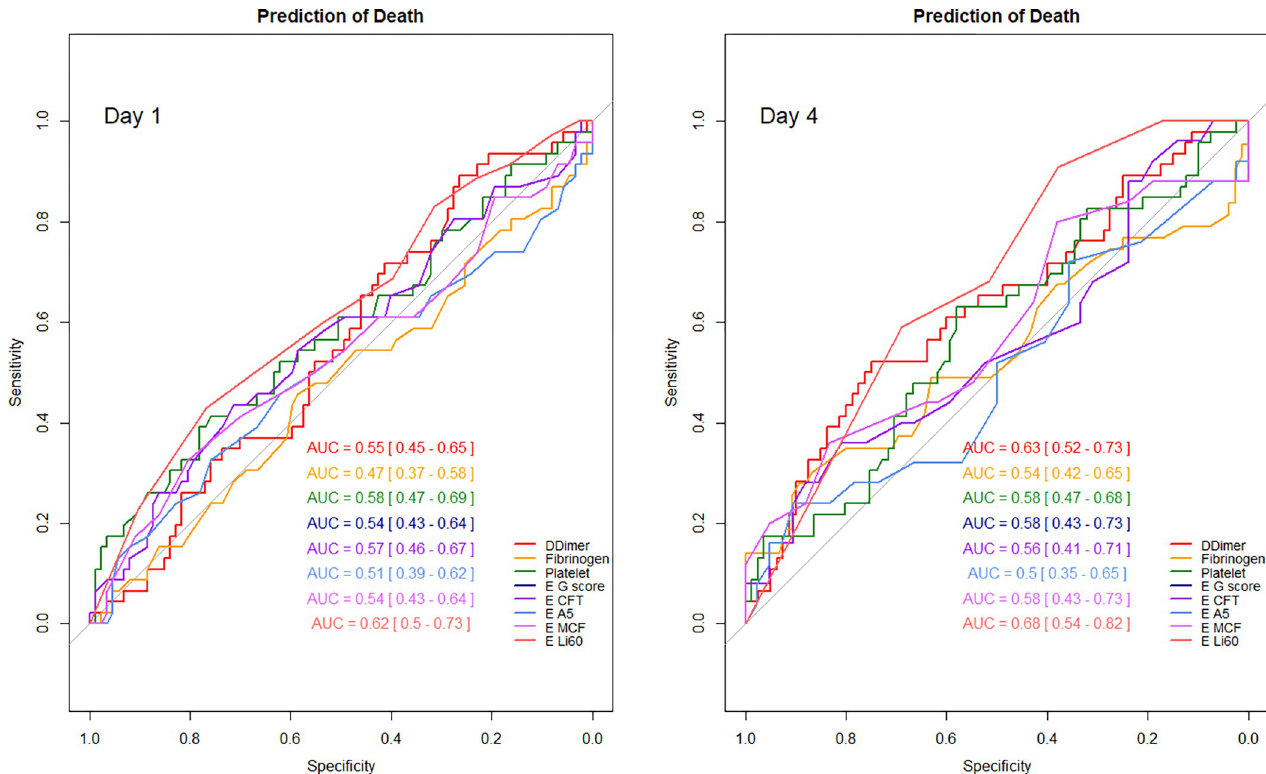
Fig 5. Prediction of ICU death by coagulation indices on day 1 and day 4. AUC: Area Under the Curve; E: EXTEM; CFT: Clot formation time; A5: Clot amplitude 5 minutes after clotting time; MCF: Maximum clot firmness; Li60: Lysis index at 60 minutes.